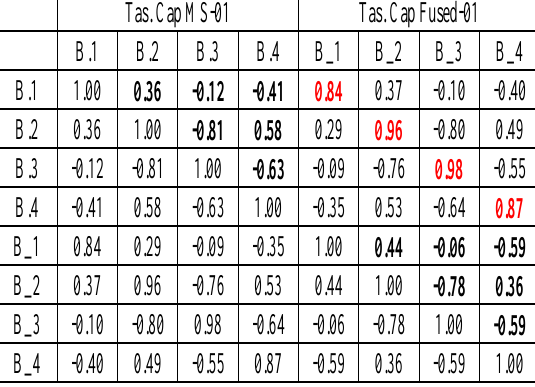
Table 8. Correlation matrix between the bands (B) of Tasselled Cap MS-01